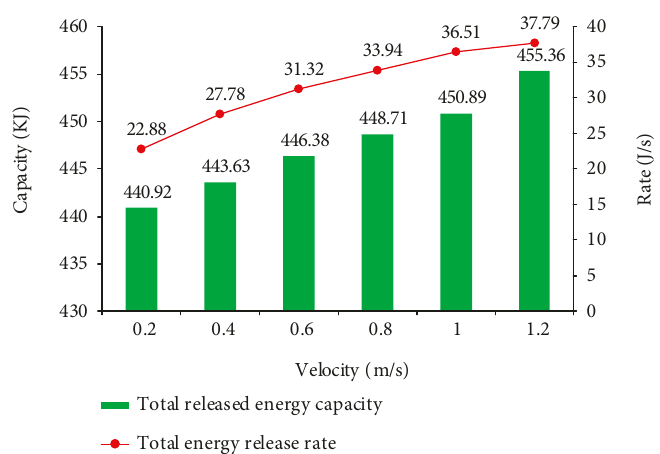
Figure 17: E ff ects of inlet velocity of HTF on the total released energy capacity and energy release rate.